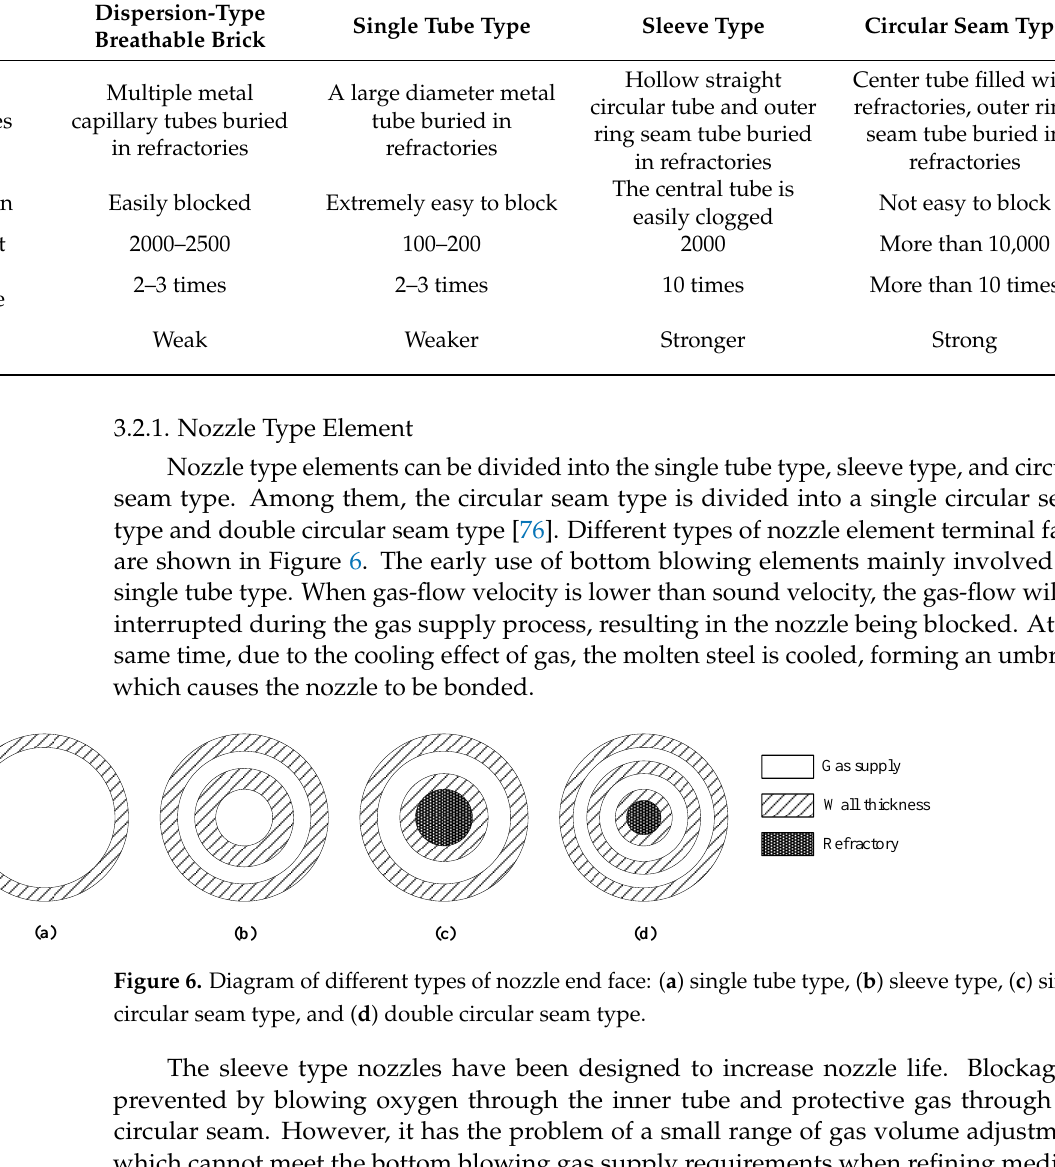
Table 5. Comparison of the structural characteristics and performance of bottom blowing ele- ments.